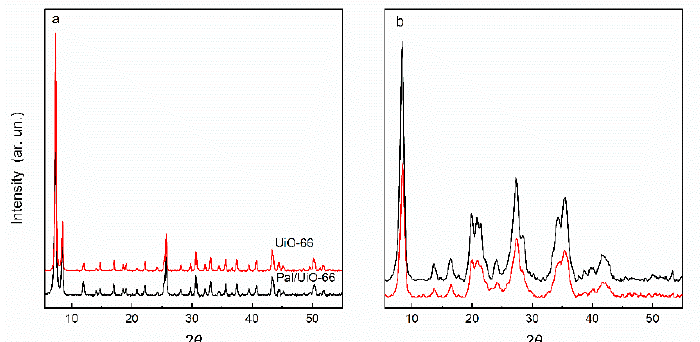
Figure 2. X-ray diffraction (XRD) patterns of the prepared materials, UiO-66, and the Pal/UiO-66 composite ( a ) and the Pal sample before and after being treated under the synthesis conditions ( b ).